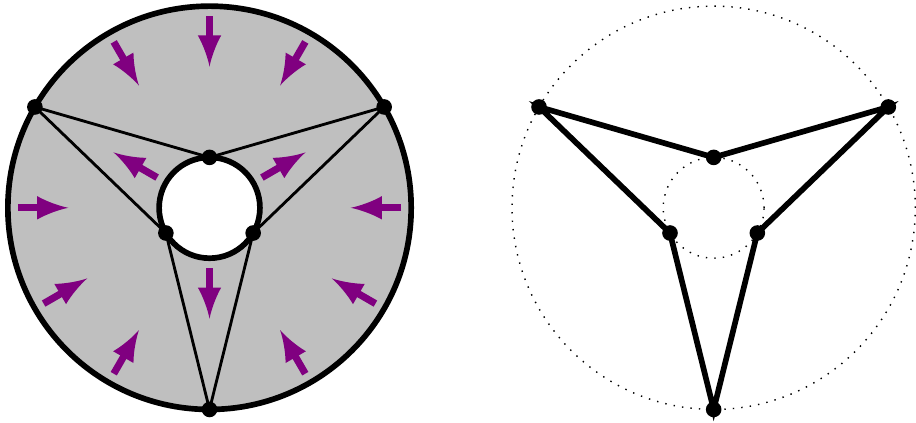
Figure 8. All triangle are squashed so the ring is reduced to a closed path homotopic to a circle.